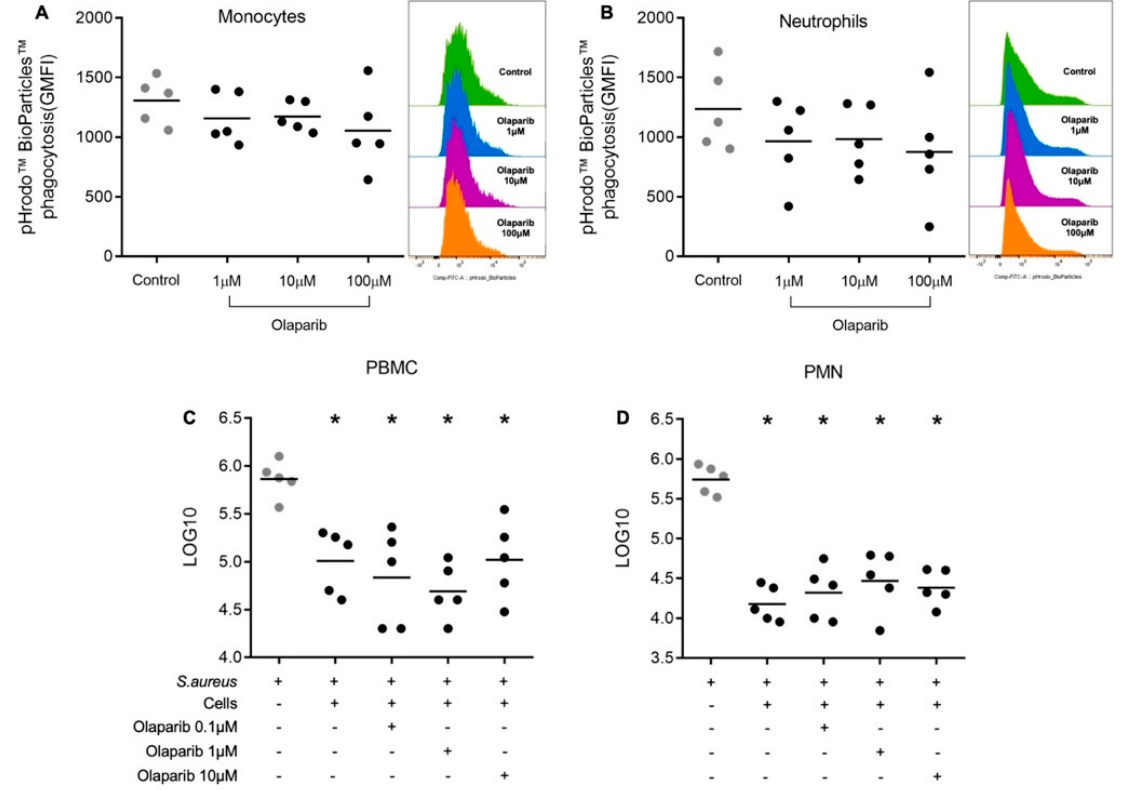
Figure 5. Effect of olaparib on S. aureus killing by human leukocytes. Phagocytosis was measured in monocytes ( A ) and neutrophils ( B ). Whole blood from five healthy individuals was pre-incubated with olaparib at different concentrations (1–100 µM) for 4 h, followed by incubation with pHrodo™ Green E. coli BioParticles™. Data are shown as geometric mean fluorescence intensity. Killing activity against S. aureus was measured in PBMCs ( C ) and PMNs ( D ) from five healthy volunteers in the presence of increasing concentrations of olaparib (0.1–10 µM). Cells were pre-incubated with the PARP inhibitor for 1 h, and then S. aureus was added to the cells. The control condition refers to the growth of S. aureus colonies in the absence of PBMCs or PMNs. Results are expressed as log 10 CFU. * p < 0.05 compared to the control condition (ANOVA followed by Tukey’s test).